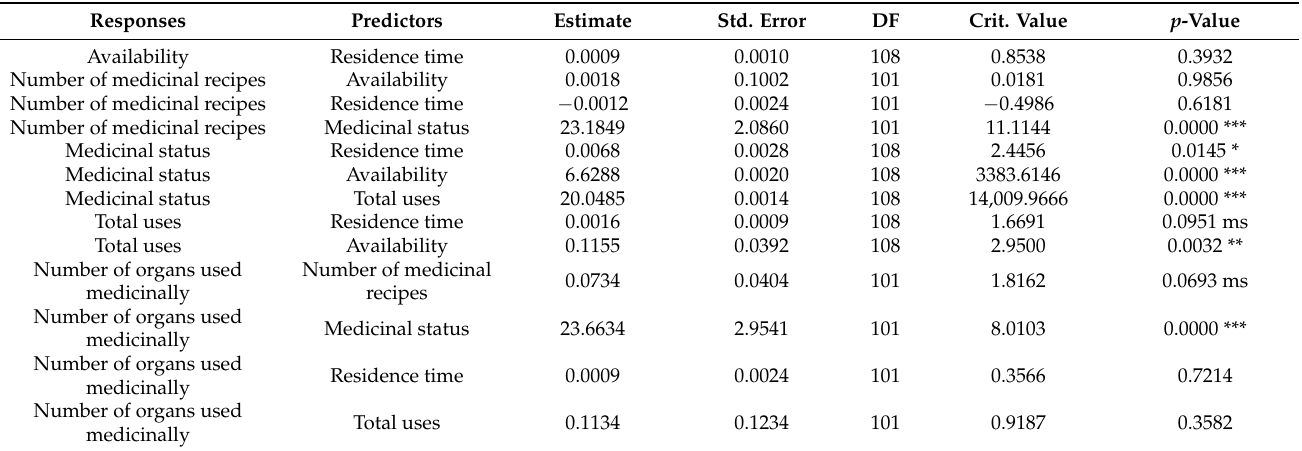
Table 1. Coefficients of all relationships tested in the Structural Equation Model (SEM) that illustrates the time-since-introduction theory. p -values in bold correspond to statistically significant relationships. Two of the relationships were only marginally significant (ms; p < 0.10), but the remaining significant relationships were more so at p < 0.05). The number of stars (*) indicates the significant level of a